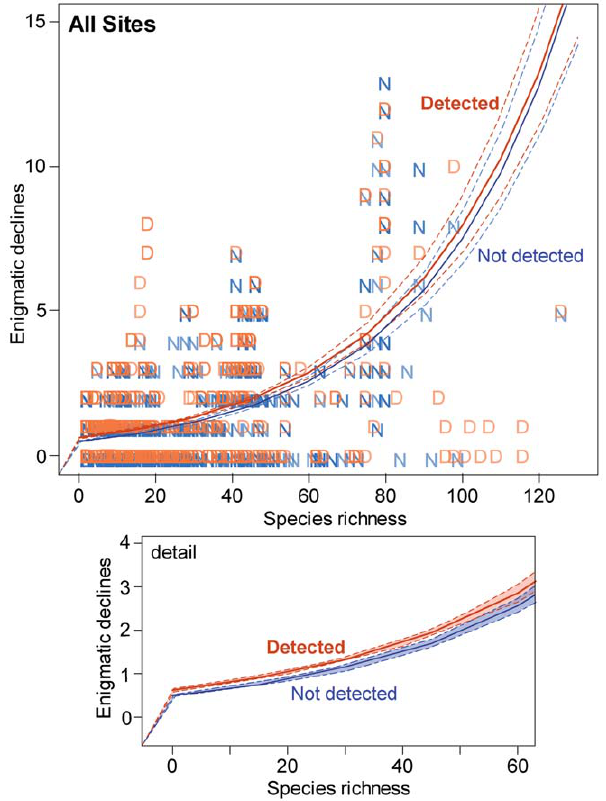
Figure 2. Global locations with enigmatic amphibian declines were positively associated with amphibian species richness (data from GAA [ 7 ] ), and this relationship increased with the occurrence of the amphibian chytrid fungus, Batrachochytrium dendrobatidis , as modeled with logistic regression. Dashed lines indicate 95% confidence